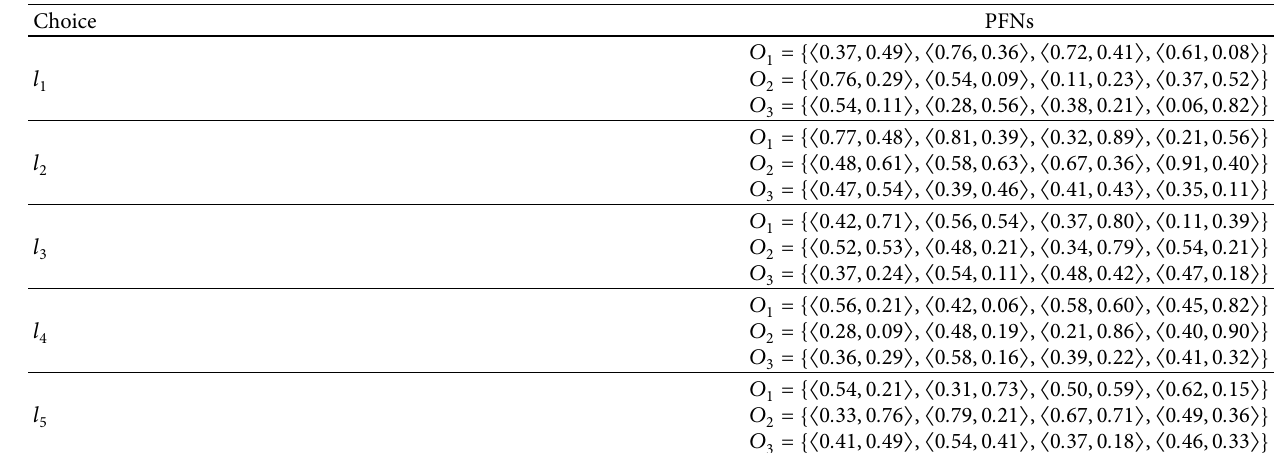
Table 2: P m FNs for each